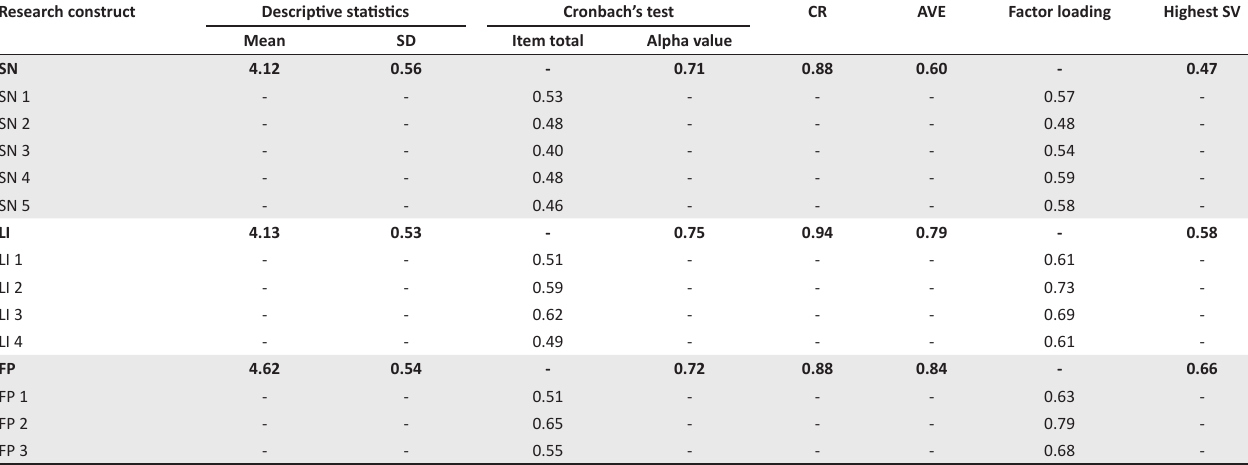
TABLE 3: Accuracy analysis